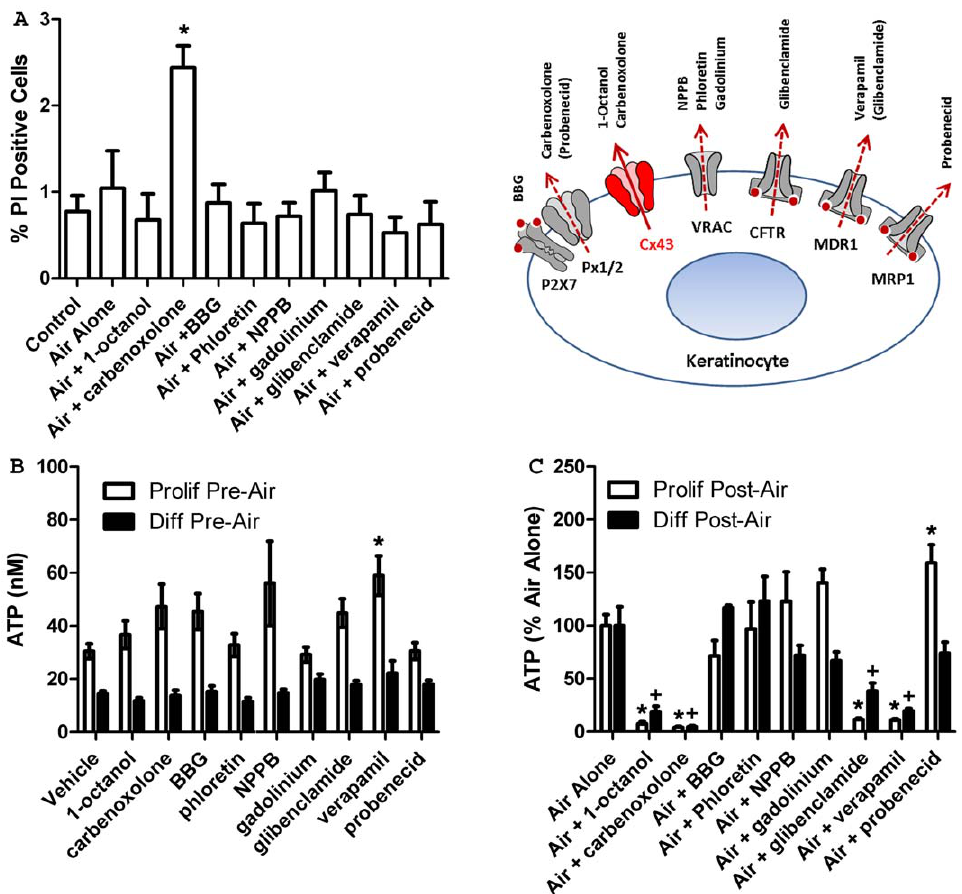
Figure 3. Pharmacological analysis of the air-stimulated ATP release mechanism. A. propidium iodide (PI) labeling. PI labeling was measured to ensure that air exposure and drugs used in inhibition experiments did not compromise cell membranes. Only pretreatment with carbenoxolone significantly increased PI labeling and this remained below 3% of cells. All values represent averages + / 2 SEM of 6 dishes per group, * p , 0.05 vs. control. To determine the mechanism of air-stimulated ATP release , keratinocytes were pre-incubated for 10 minutes with known inhibitors of ATP release pathways before air exposure. ATP levels in the media were assayed just prior to air exposure to determine any effects of the drugs themselves on baseline ATP release ( B , pre-air) and 7 minutes after air exposure ( C , post-air) to measure the ability of drugs to inhibit air- stimulated ATP release. B . Pre-air ATP levels were significantly lower in differentiated cultures, but similar for most drug treatment groups. C . In both proliferating and differentiated cultures, pre-incubation with the connexin hemichannel blockers 1-octanol and carbenoxolone largely abolished air- stimulated ATP release. Glibenclamide and verapamil, drugs traditionally used as ABC transporter blockers, also significantly inhibited air-stimulated ATP release. Post-air ATP levels are expressed as percent of air alone. Values represent 12 (drug treatment) or 24 (air alone) dishes. Error bars are + / 2 SEM, *, + p , 0.05 vs. vehicle or air alone for proliferating and differentiated cells, respectively. Inset. Schematic showing potential keratinocyte ATP release pathways and the major targets of inhibitors used. Secondary targets discussed in the text are also shown in parentheses. Red dots and arrows represent regulatory ATP binding sites and routes of release, respectively. Release Pathways. P2X7: P2X7 ATP receptors, Px1/2: pannexins-1 & 2, Cx43: connexin-43, VRAC: volume-regulated anion channels (unknown molecular identity) and the ATP binding cassette (ABC) transporters CFTR, MDR1 and MRP1.